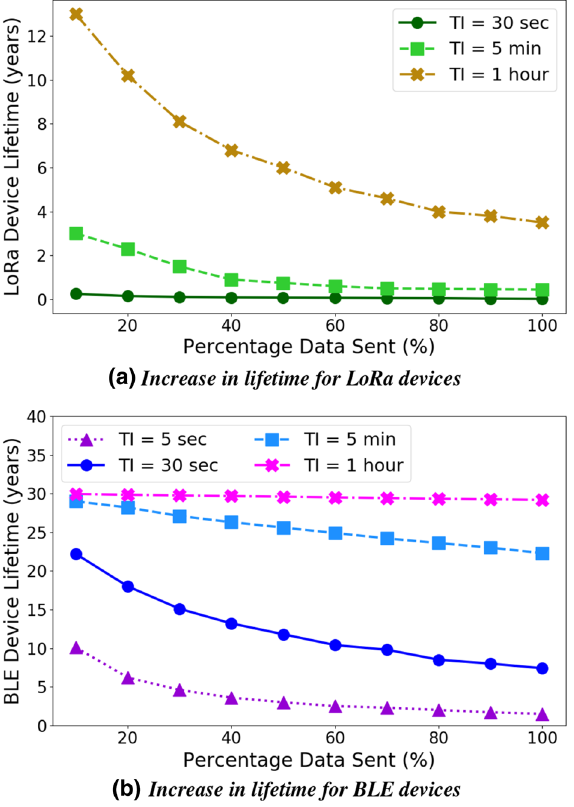
Figure 7. Increase in IoT sensor node lifetime due to reduction in data transmission; TI is the transmission interval, thus we have low traffic intensity (TI = 1 h) to high traffic intensity (5 s in BLE, 30 s in LoRa). The gain of Ambrosia is significantly higher for higher traffic intensity and is available for both wireless technologies LoRa and